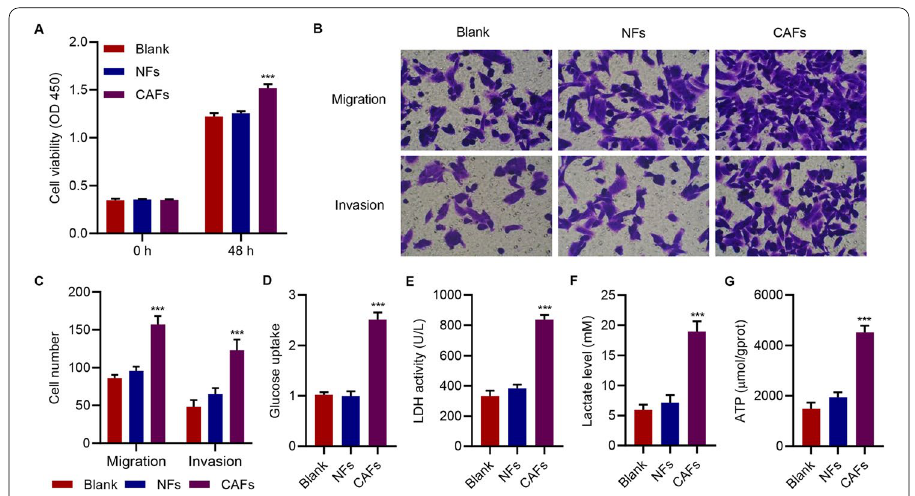
Fig. 1 CAFs promoted migration, invasion, and glycolysis in HepG2 cells. Effects of CAFs and NFs on the ( A ) viability, ( B , C ) migration, and ( B , C ) invasion of HepG2 cells. Effects of CAFs and NFs on ( D ) glucose uptake, ( E ) LDH activity, ( F ) lactate levels, and ( G ) ATP content of HepG2 cells. The data are expressed as the mean (n 3). *** P < 0.001 compared with blank (HepG2 cells without =